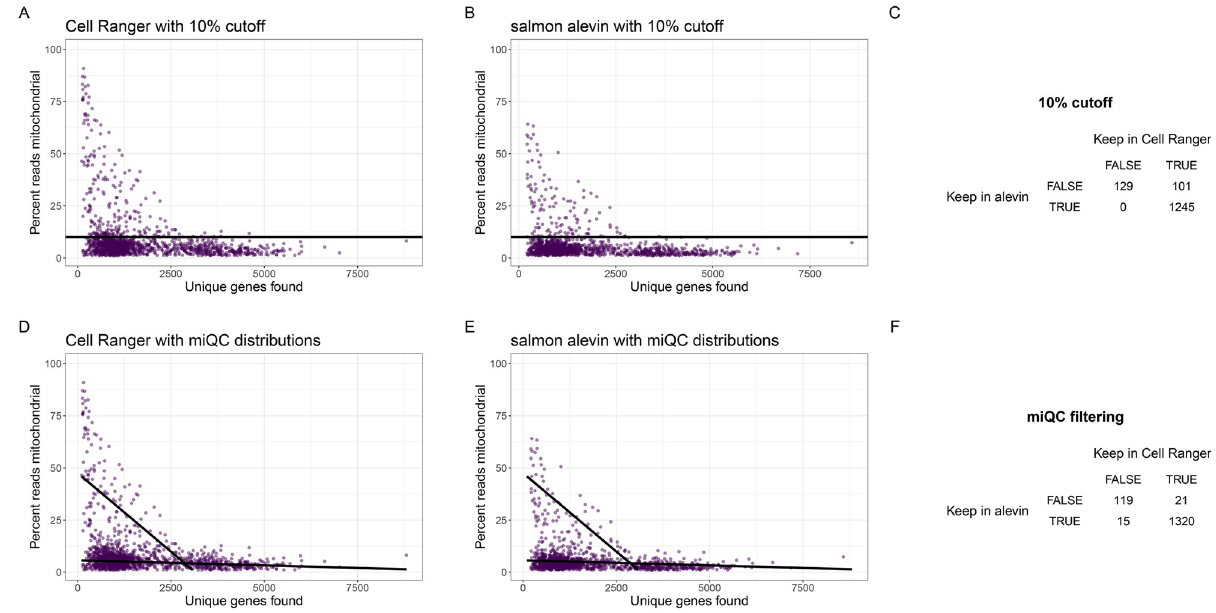
Fig 4. miQC is adaptive across the choice of reference genome used. Cells ( N = 1733) from one high-grade serous ovarian cancer (HGSOC) tissue sample (Sample ID: EOC871) with the number of unique genes found ( x -axis) and percent of cell counts mapping to mitochondrial (mtDNA) genes ( y - axis). Quantification of cell counts was performed with (A) Cell Ranger using the GrCh38 reference genome (version 2020-A) and (B) salmon alevin with the GENCODE reference genome (release 31). In both (A-B), we use a 10% mtDNA threshold (as recommended by Osorio and Cai [16]) for this human cancer sample to remove compromised cells. (C) A confusion matrix of how cells are filtered differently by this uniform threshold using the different reference genomes, resulting in a large number of cells removed after QC using either reference genome, but differences in which cells are removed depending on the choice of reference genome. (D-E) Using the same tissue sample as (A-C), but here we use our miQC approach to fit a finite mixture of standard linear regression models with two lines (black lines) to calculate the posterior probability of being a compromised cell. (F) A confusion matrix of which cells are filtered by our miQC approach which not only results in a larger number of predicted intact cells after QC, but also results in a smaller number of discrepancies between which cells are included after QC.